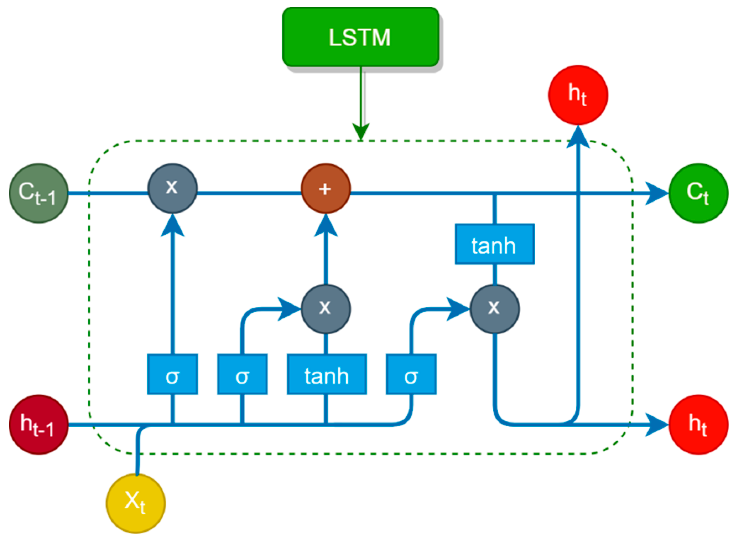
Figure 4. Long short-term memory (LSTM) architecture.